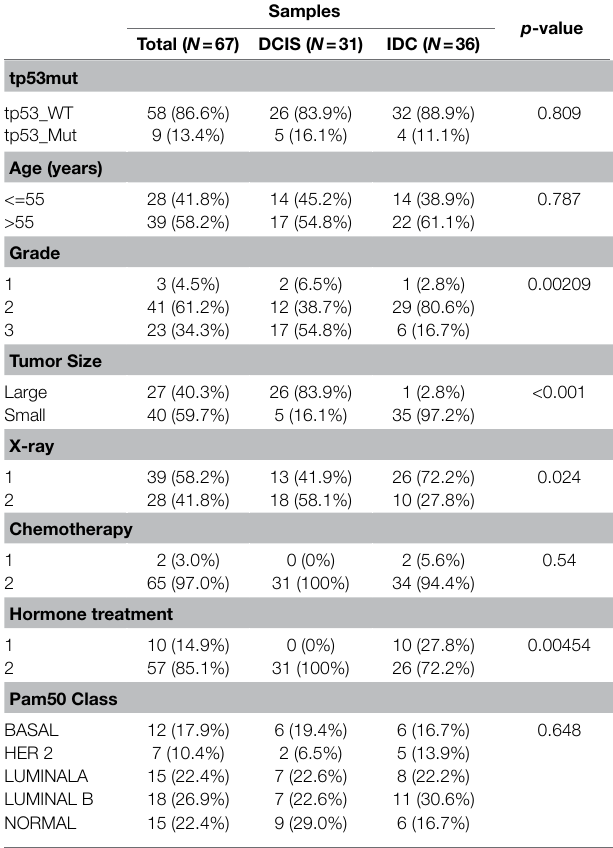
TABLE 1 | Statistical analysis of clinical characteristics of IDC/DCIS patients in the GSE26304 data set.